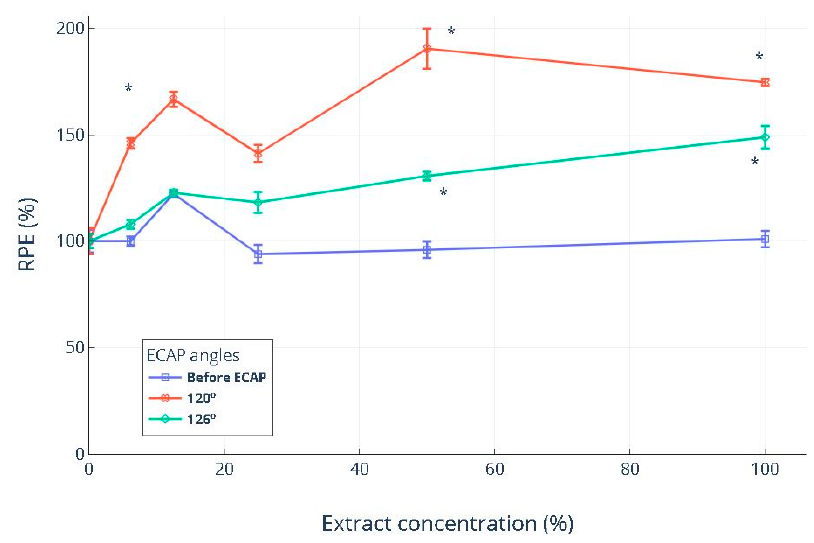
Figure 8. Cytotoxicity of SS316L samples evaluated by extract method (mean ± sd). * p < 0.05 to control samples.